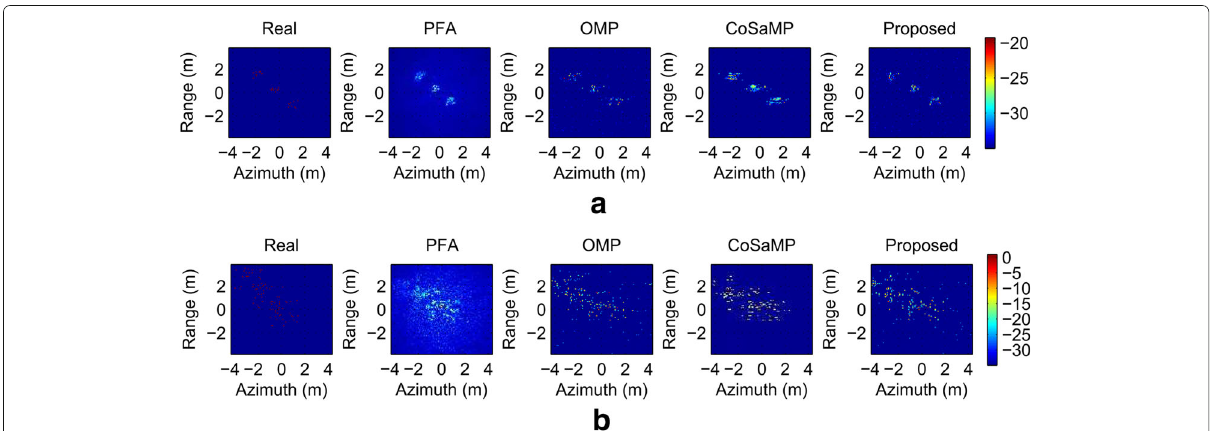
Fig. 3 SAR imaging for ideal point scatterer model under different number of scatterers. a 30 scatterers. b 150 scatterers